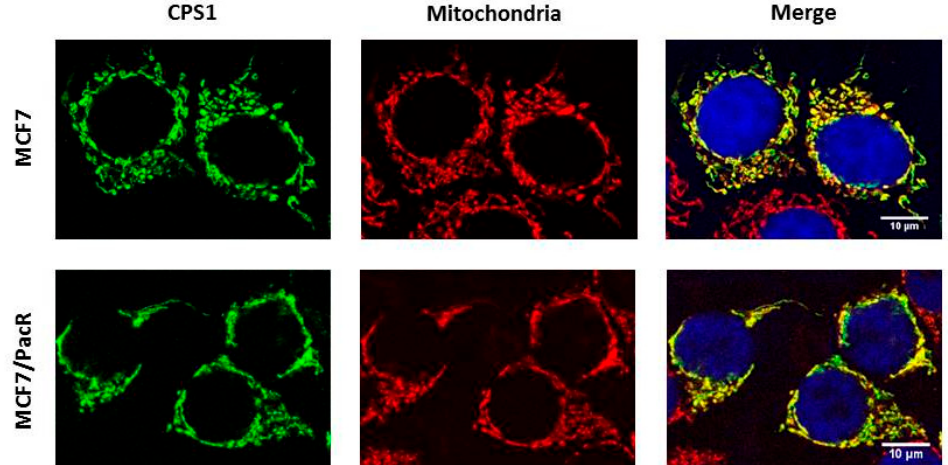
Figure 5. Cellular distribution of CPS1 (carbamoyl-phosphate synthetase 1) in paclitaxel-sensitive MCF7 cells and paclitaxel-resistant MCF7/PacR cells. The localization of CPS1 was detected using confocal microscopy (see Section 4). The localization of CPS1 (green), mitochondria (red), nuclei (blue) and the merge are shown. The data shown were obtained in one representative experiment of two independent experiments.